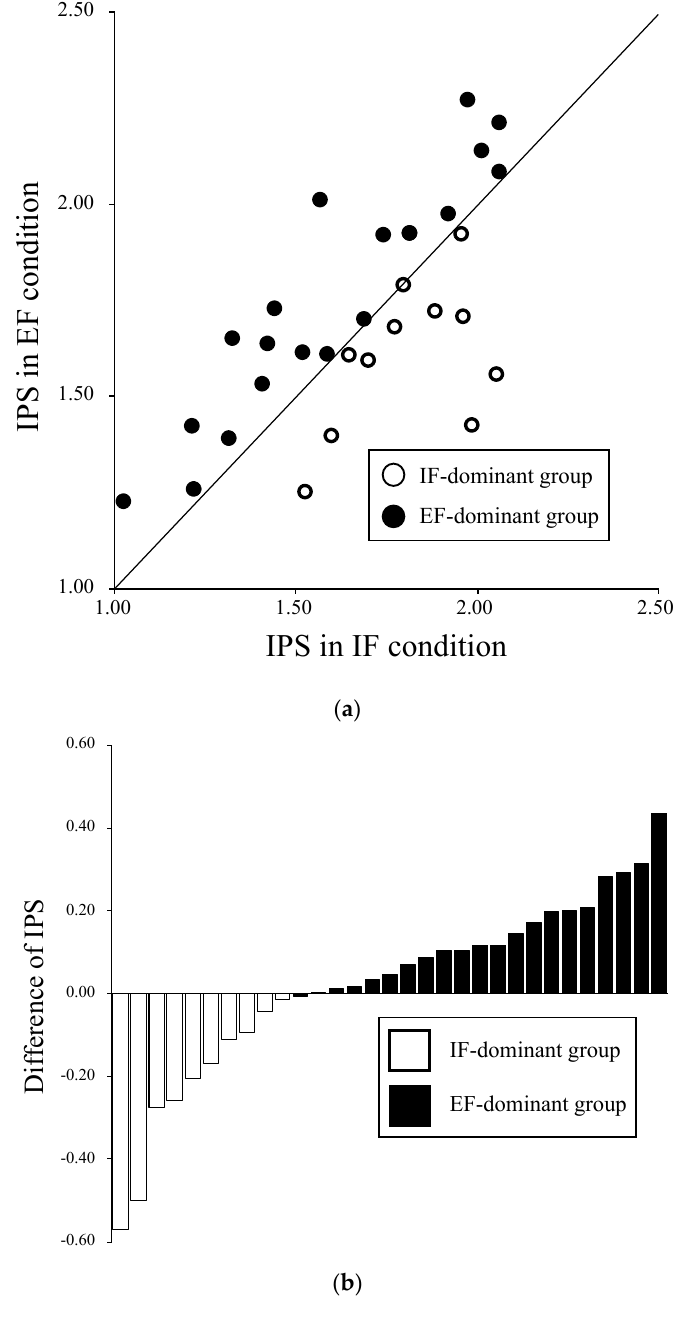
Figure 4. ( a ) The scatter plot depicts the IPS in the IF and EF conditions. Participants whose IPS in the EF condition was higher than that in the IF condition were classified as the IF-dominant group. Those whose IPS in the EF condition was higher than that in the IF condition were classified as the EF-dominant group. ( b ) The EF-dominant group included participants with a positive difference in IPS. By contrast, participants with a negative difference of IPS were included in the IF-dominant group. EF: external focus; IF: internal focus; IPS: index of postural